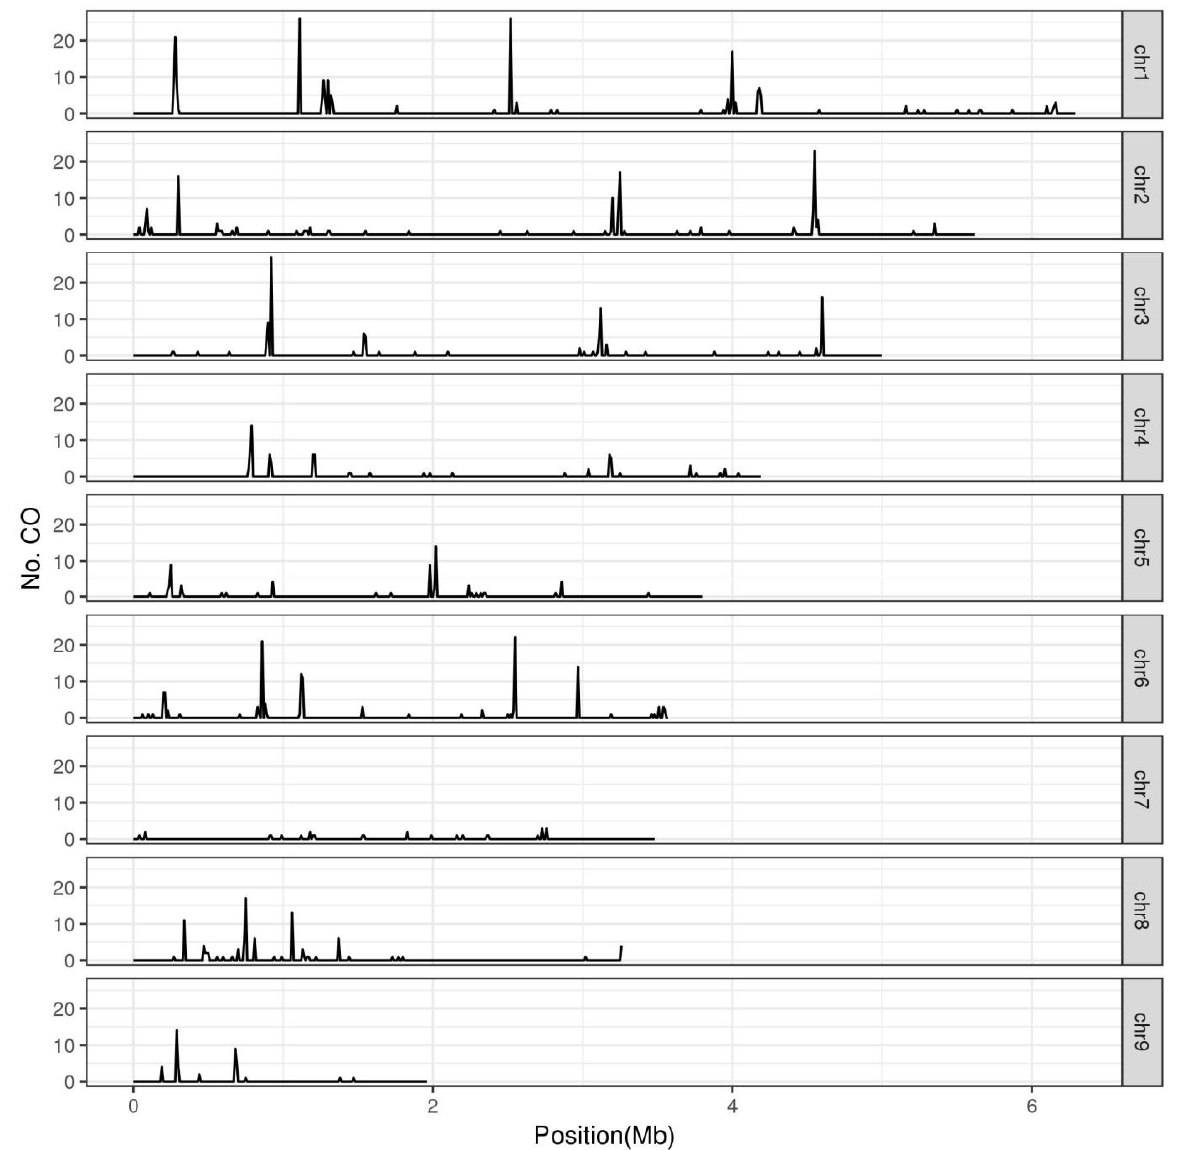
Figure 1. Distribution of crossover events along the chromosomes of L. edodes . The L. edodes genome was divided into non-overlapping 10 kb windows and recorded the crossover events of each window. The regions, for which no less than four crossovers per 10 kb segment were identified as crossover hotspots.